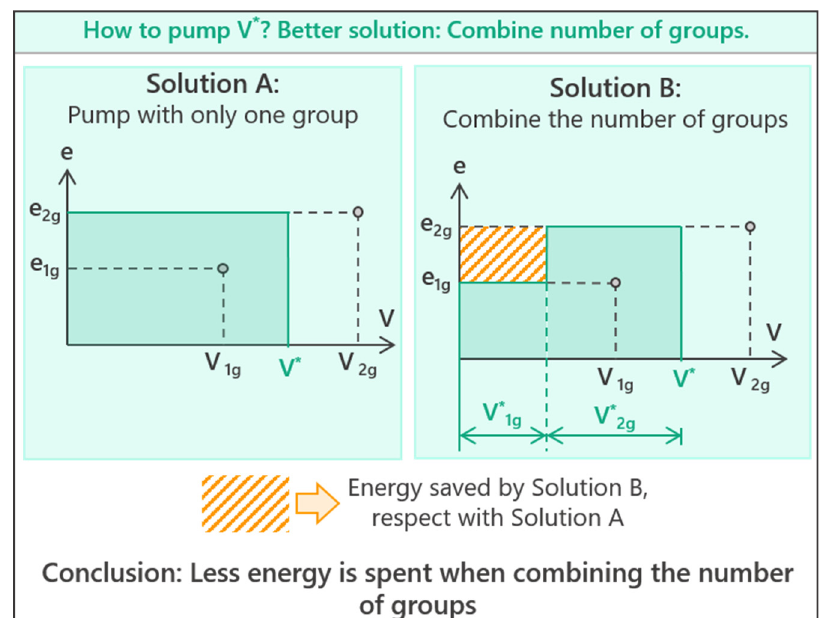
Figure 6. Solution comparison.